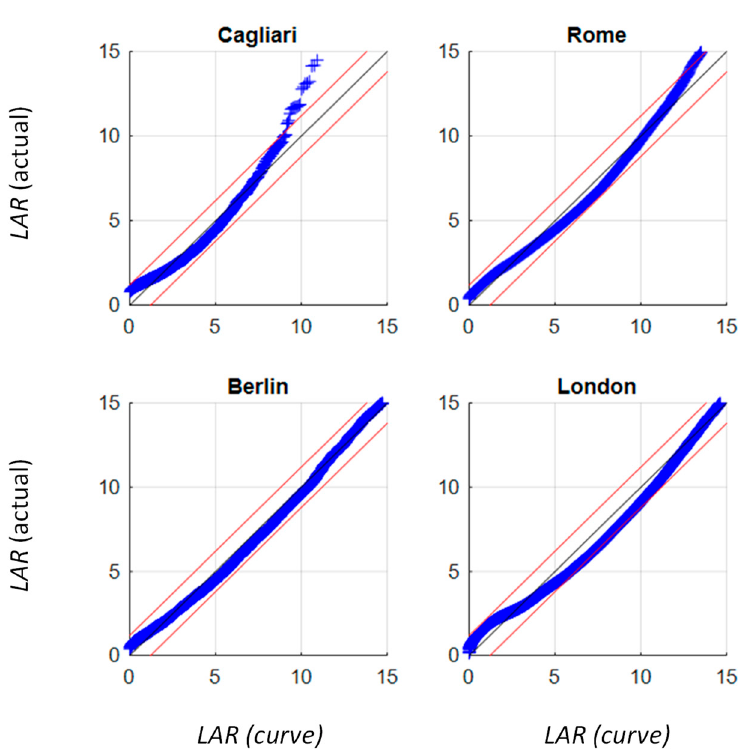
Figure 14. Q-Q plots for LAR ; actual data on the Y -axis, best-fit curves on the X -axis; the black line is the bisector, the two red straight lines highlighting a tolerance interval.